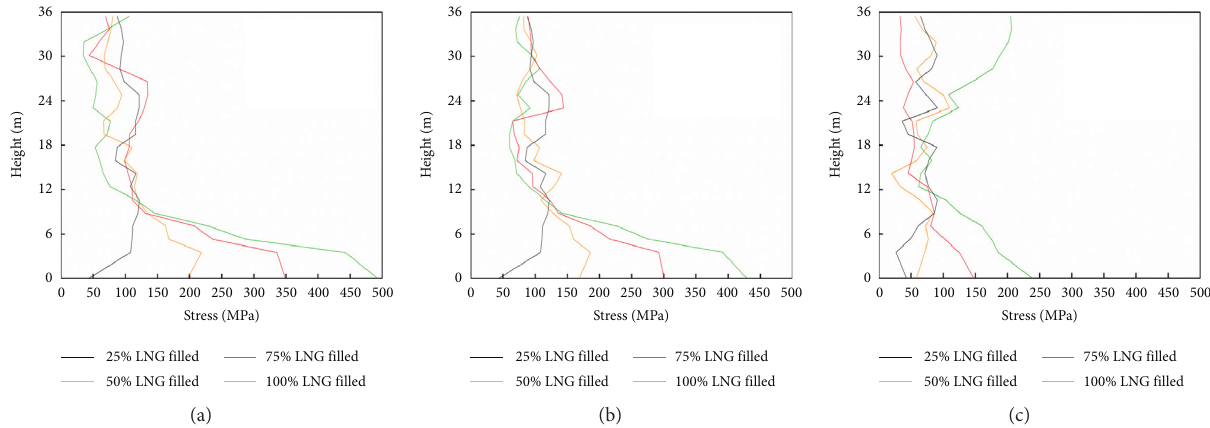
Figure 14: Distribution of von Mises stress on inner tank with respect to height along different paths. (a) Path A. (b) Path B. (c) Path C.